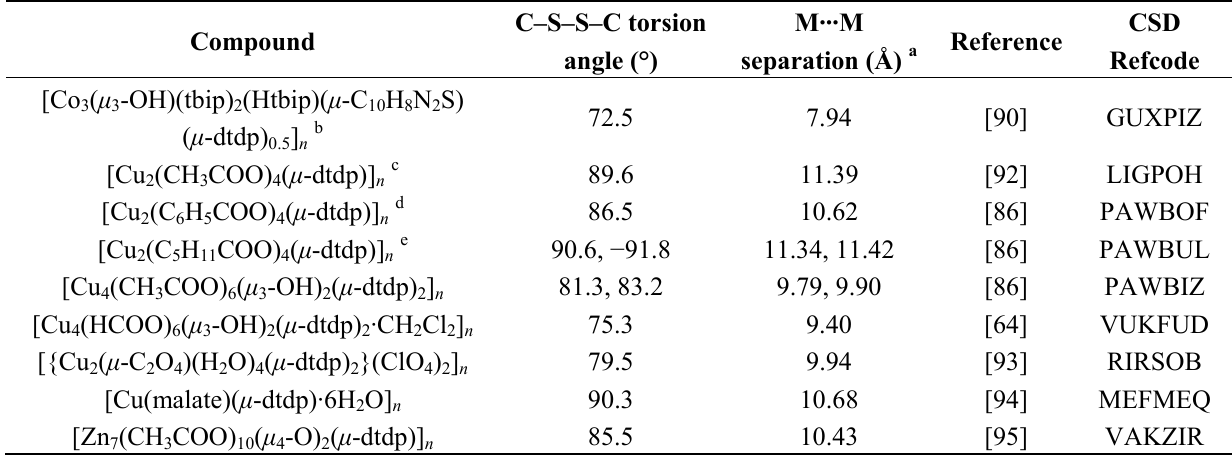
Table 5. Selected structural parameters for coordination polymers based on metal carboxylate clusters.